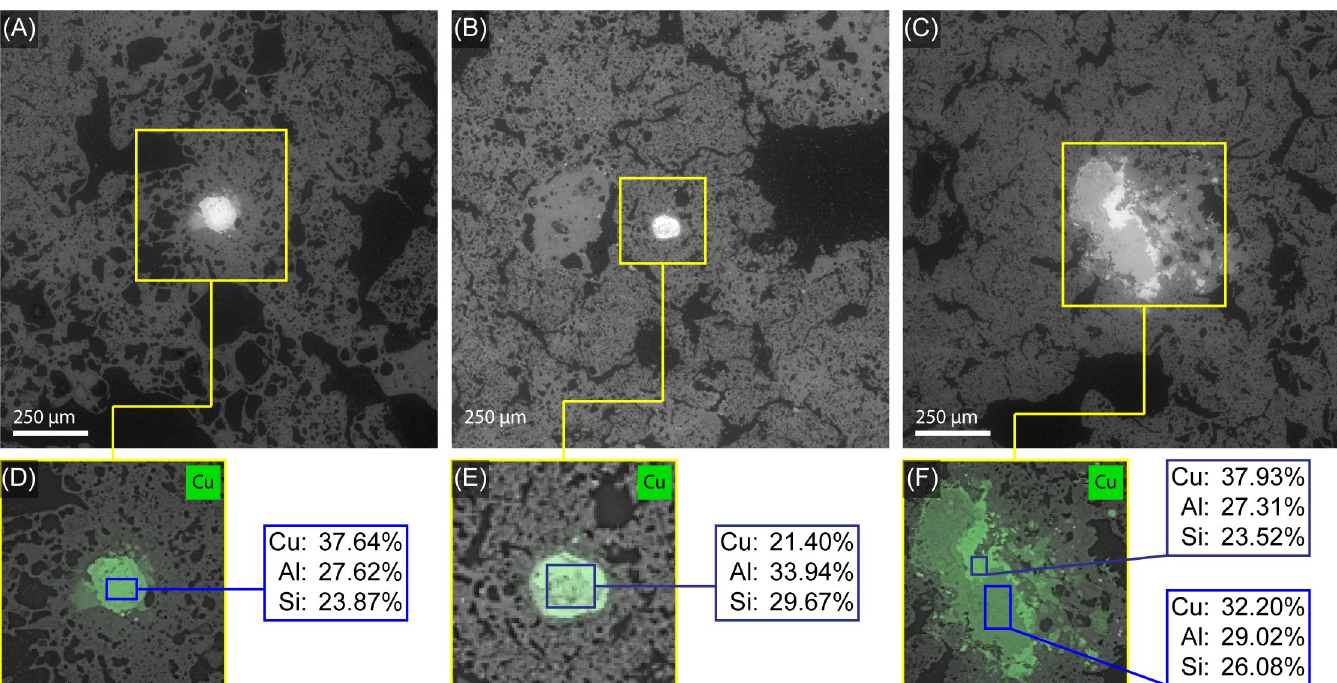
Fig 10. SEM-EDS Analysis of copper prills in tuy è re M-55. (A-B) Backscattered electron (BSE) micrographs of copper prills. (C) BSE micrograph of copper-rich region in the tuy è re. (D-F) Distribution of copper identified using EDS in the regions identified in (A-C) and quantified results (mass percent) of the three major elements identified. Images by Jennifer Meanwell and Linda Seymour.